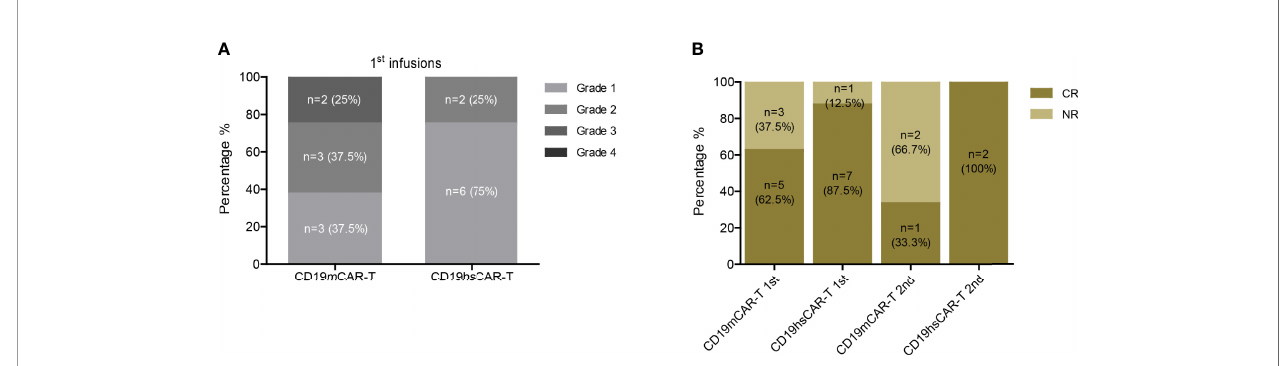
FIGURE 2 | Safety and ef fi cacy of CD19hs CAR-T. (A) CRS following CD19m CAR-T and CD19hs CAR-T infusions. (B) CR rates after the 1 st and 2 nd infusions of CD19m CAR-T and CD19hs CAR-T,